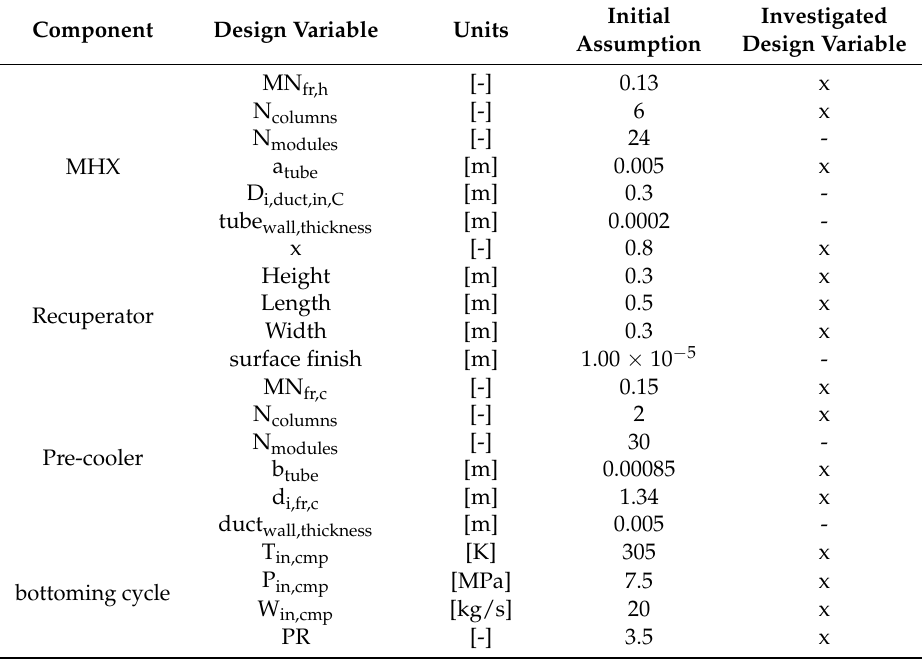
Table A2. Bottoming cycle component design